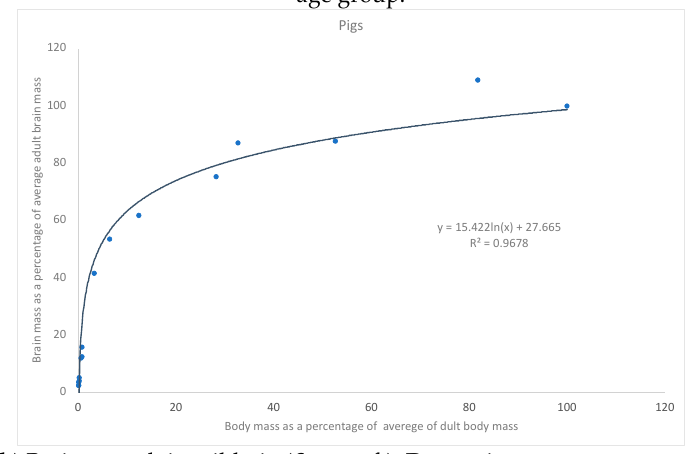
( h ) Brain growth in wild pig ( Sus scrofa ). Data points represent average